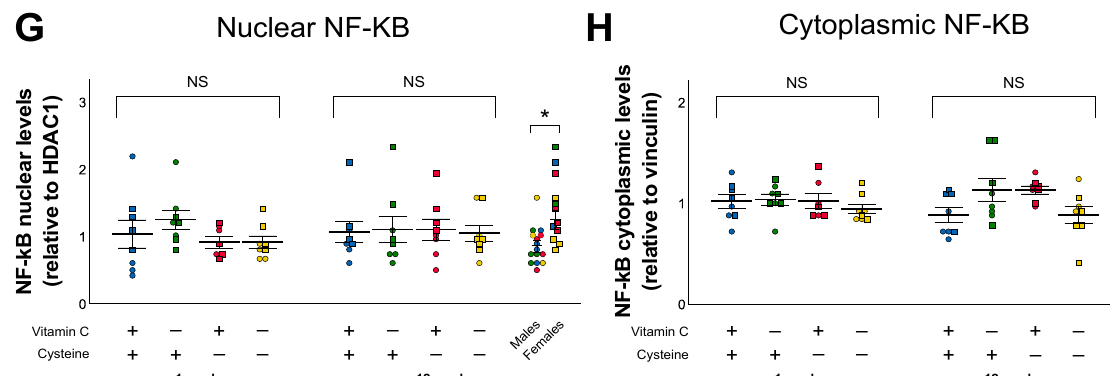
Figure 3. Hepatic levels of GSH, GSSG, redox potential of glutathione, Nrf2, and NF- κ B in nucleus and cytoplasm in 1-week- and 12-week-old animals. ( A ). GSH levels were decreased in vitamin C and cysteine deficient animals at 1 week of life. At 12 weeks of life, early-life vitamin C deficiency decreased GSH, while early-life cysteine deficiency increased it. ( B ). At 12 weeks, cysteine deficiency increased GSSG levels. ( C ). The redox potential of glutathione was oxidized (increased) by both deficiencies at 1 week of life. At 12 weeks, redox potential was oxidized by early-life vitamin C deficiency. ( D ). Western blot images from Nrf2 and NF- κ B, with HDAC1 and vinculin as reference proteins. ( E ). At 12 weeks of life, early-life vitamin C deficiency decreased nuclear Nrf2. ( F ). Cytoplasmic Nrf2 was increased in both vitamin C and cysteine deficiency animals at 1 week of life. ( G ). Females had increased nuclear NF- κ B at 12 weeks of life, compared to males. ( H ). No statistically significant differences were observed in NF- κ B levels in nucleus or cytoplasm either at 1 week of life or at 12 weeks. Mean ± SEM. Circles: male animals; squares: female animals; NS: statistically non-significant; *: p < 0.05; **: p < 0.01; ***: p < 0.001.